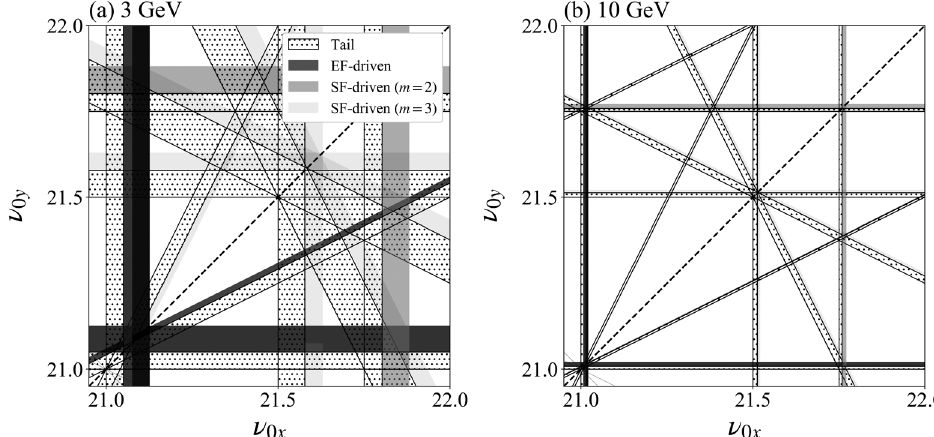
FIG. 1. Stop-band diagrams corresponding to the current operating condition of the J-PARC MR. The rms tune depression is estimated to be (a) η ≈ 0 . 994 at 3 GeVand (b) η ≈ 0 . 999 at 10 GeV. The coherent resonance bands of up to the third-order ( m ≤ 3 ) are plotted on the basis of Eq. (3) with C 2 ¼ 0 . 7 and C 3 ¼ 0 . 8 . The third-order resonance driven by the normal sextupole magnets for orbit correction overlaps with the second-order resonance slightly above ν 0 x ¼ 21 . The width of each stop band is defined by the approximate formula in Eq. (5). The safety factor ζ k l is set equal to unity for all stop bands. We have ignored the effect of error fields that produce additional stop